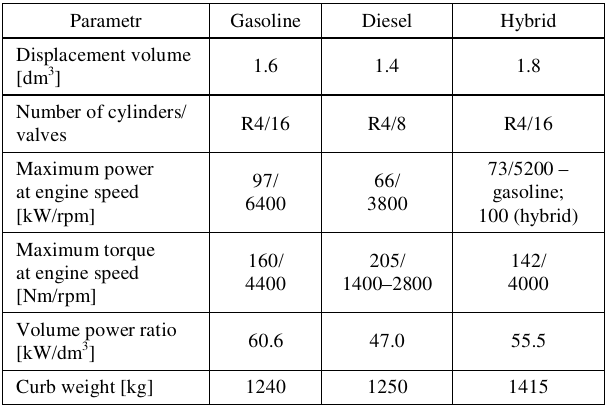
Table 1. Characteristics of the research